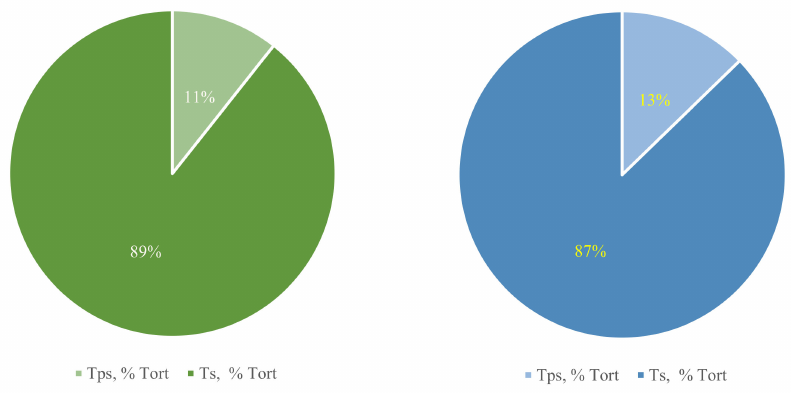
Figure 20. Ship operating profile for one round trip for 18 kn ( left ) and 22 kn ( right